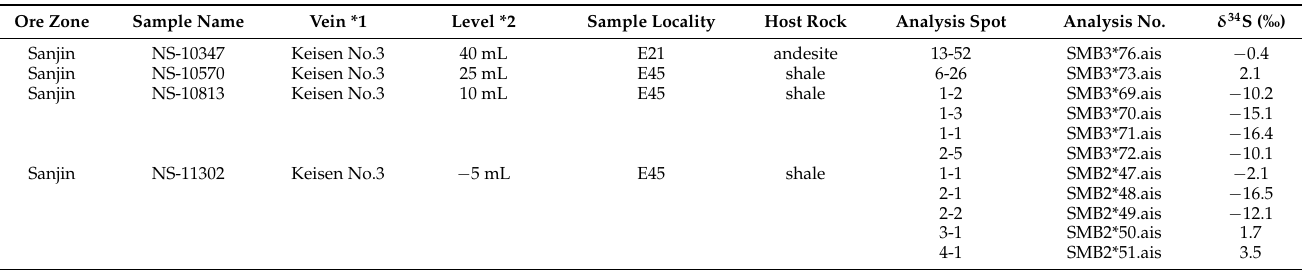
Table 5. Locality and the sulfur isotope ratio of pyrite from the Hishikari